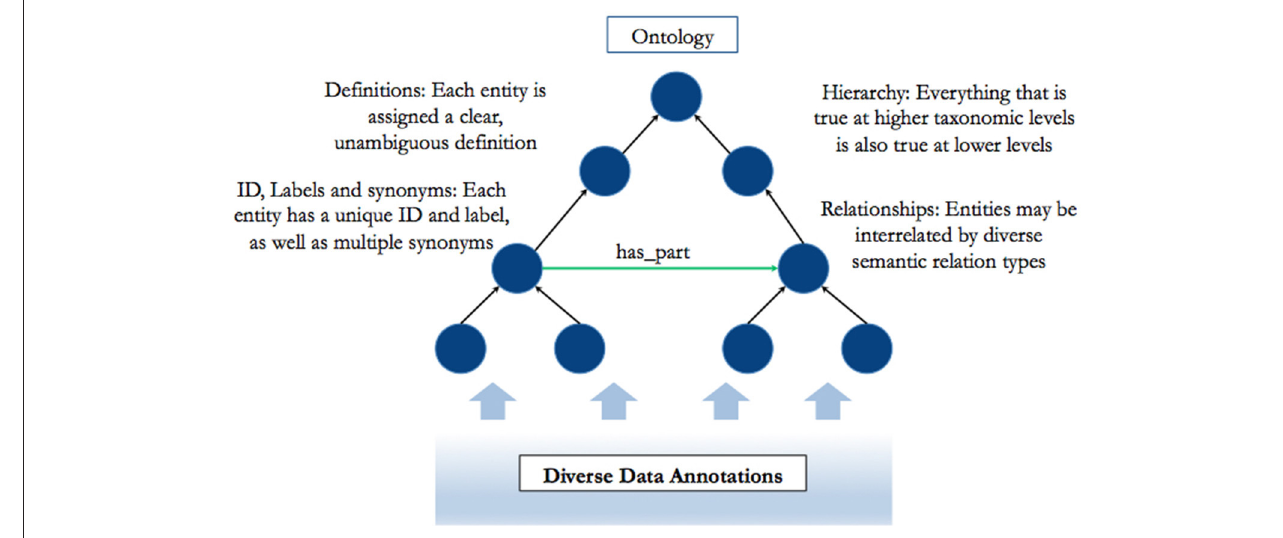
FIGURE 1 | An overview of the nature and structure of an applied